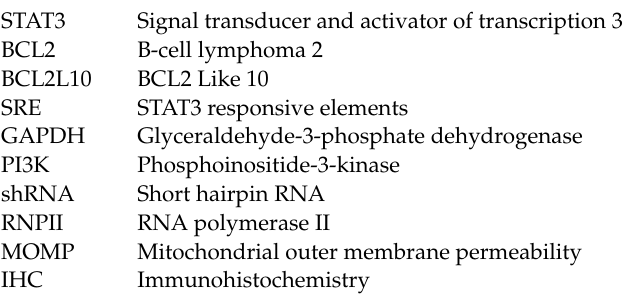
levels. Figure S5: Overlap of P-STAT3 and BCL2L10 staining in melanoma samples, Figure S6: Whole Western blot figures for Figure 3, Figure S7: Whole Western blot figures for Figure 5 Table